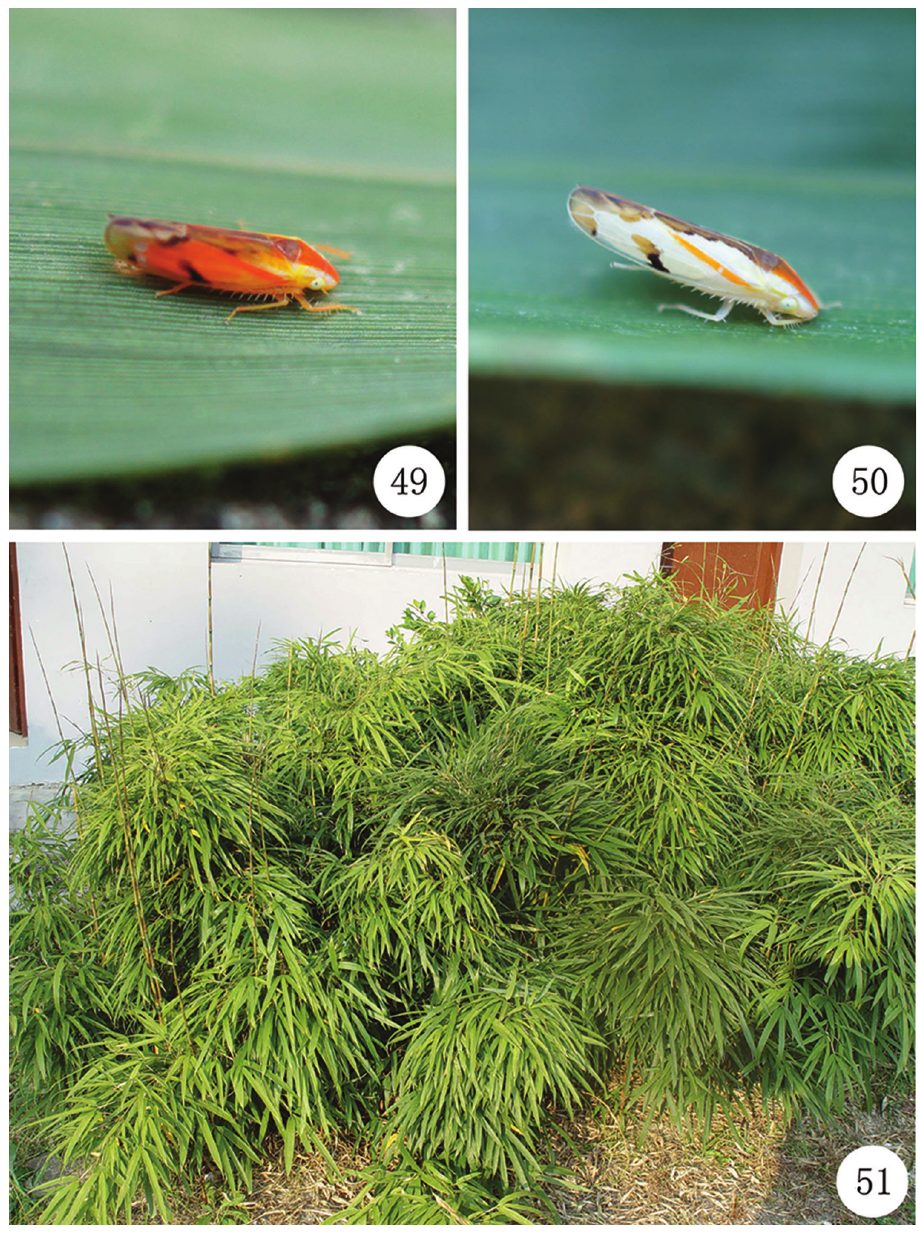
Figures 49–51. Neomohunia sinuatipenis sp. n. 49 N. sinuatipenis sp. n. resting on a leaf of host plant (bamboo)(male) 50 N. sinuatipenis sp. n. resting on a leaf of host plant (bamboo)(female) 51 The habitat photo of N. sinuatipenis sp. n. (Guizhou Province, Leishan County, Leigong Mountain, 7 September 2014, photography by Xiang-Sheng